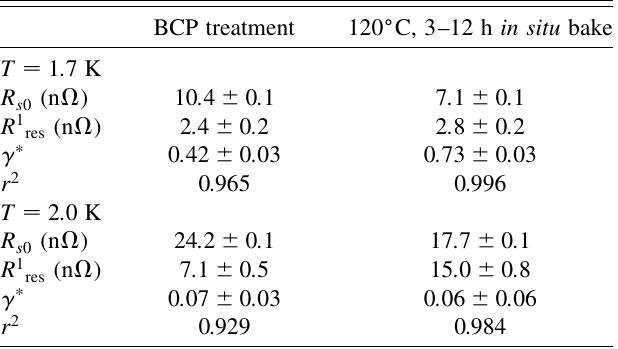
TABLE II. Weighted average values of R average values of r 2 at 1.7 and 2.0 K for a standard BCP treatment and in situ baking at 120 (cid:3) C for 3–12